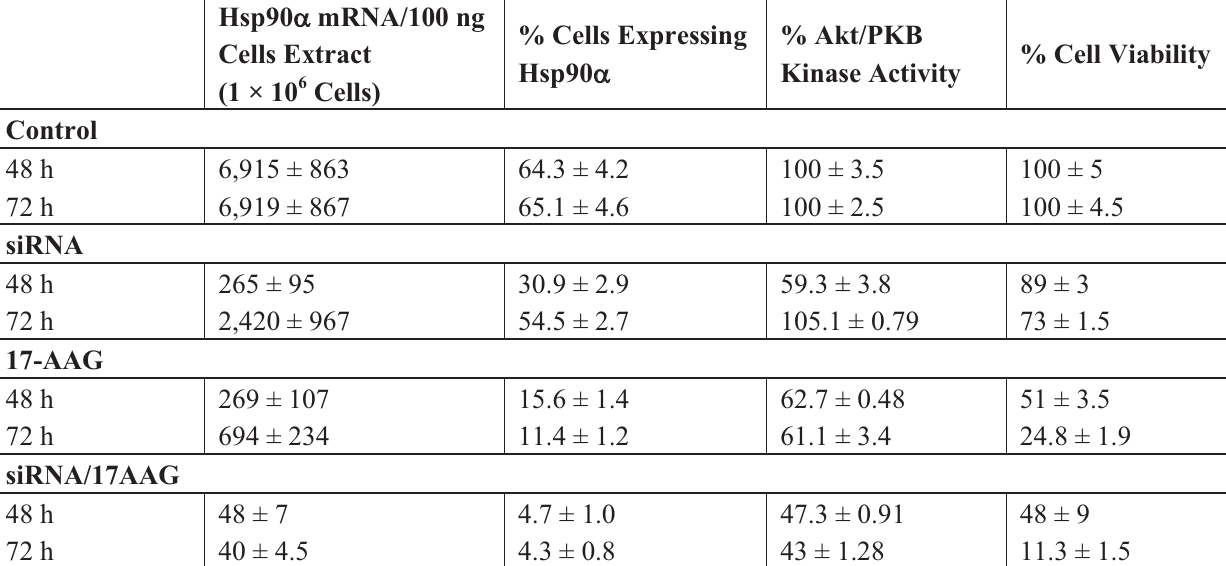
Table 3. The correlation profile between Hsp90 (cid:2) expression at mRNA and protein with Akt activity and cell viability in U87-MG cell